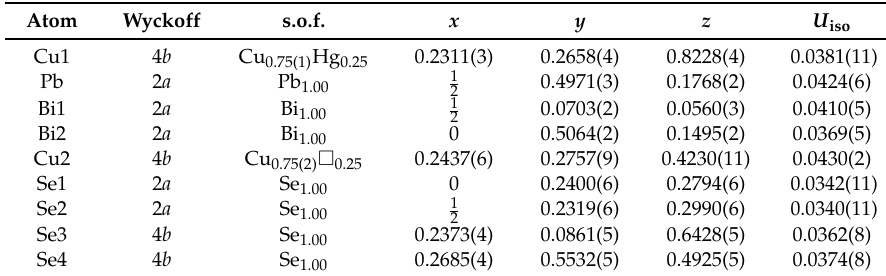
Table 6. Wyckoff positions, site occupation factors (s.o.f.), fractional atomic coordinates ( x , y , z ), and equivalent isotropic displacement parameters ( U iso , Å 2 ) for the selected quijarroite crystal.